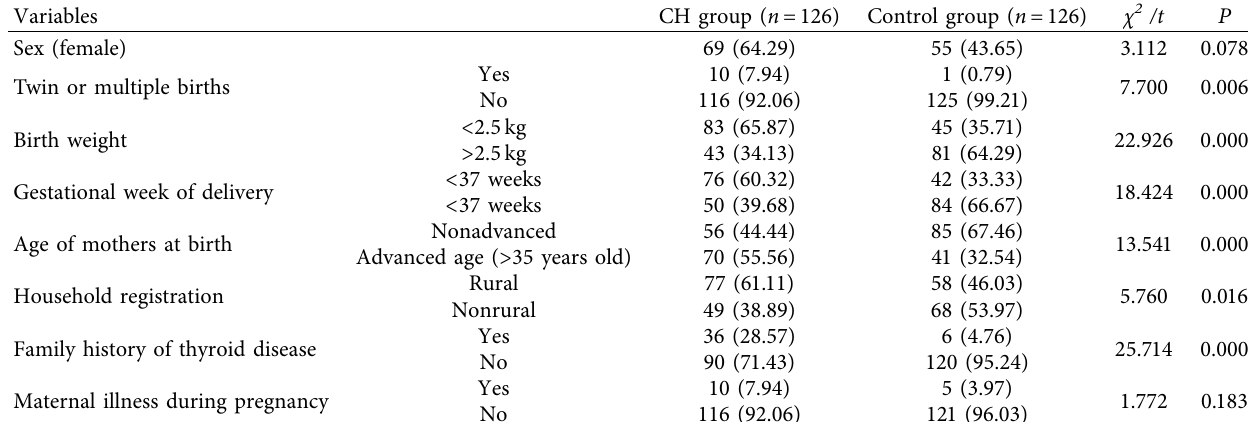
Table 2: Univariate analysis of morbidity in children with CH (n,%).